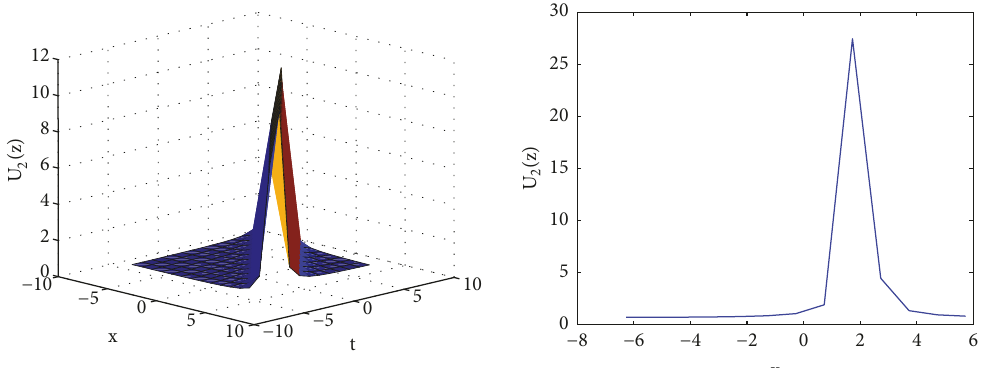
Figure 6: The 3D and 2D surfaces of 𝑈 2 (𝑧) by considering the values 𝑘 = 1 , 𝐿 = 1 , 𝜆 = 1 , 𝑦 = 0 , 𝑧 0 = 1 , and 𝑡 = 0 for the 2D graphic.